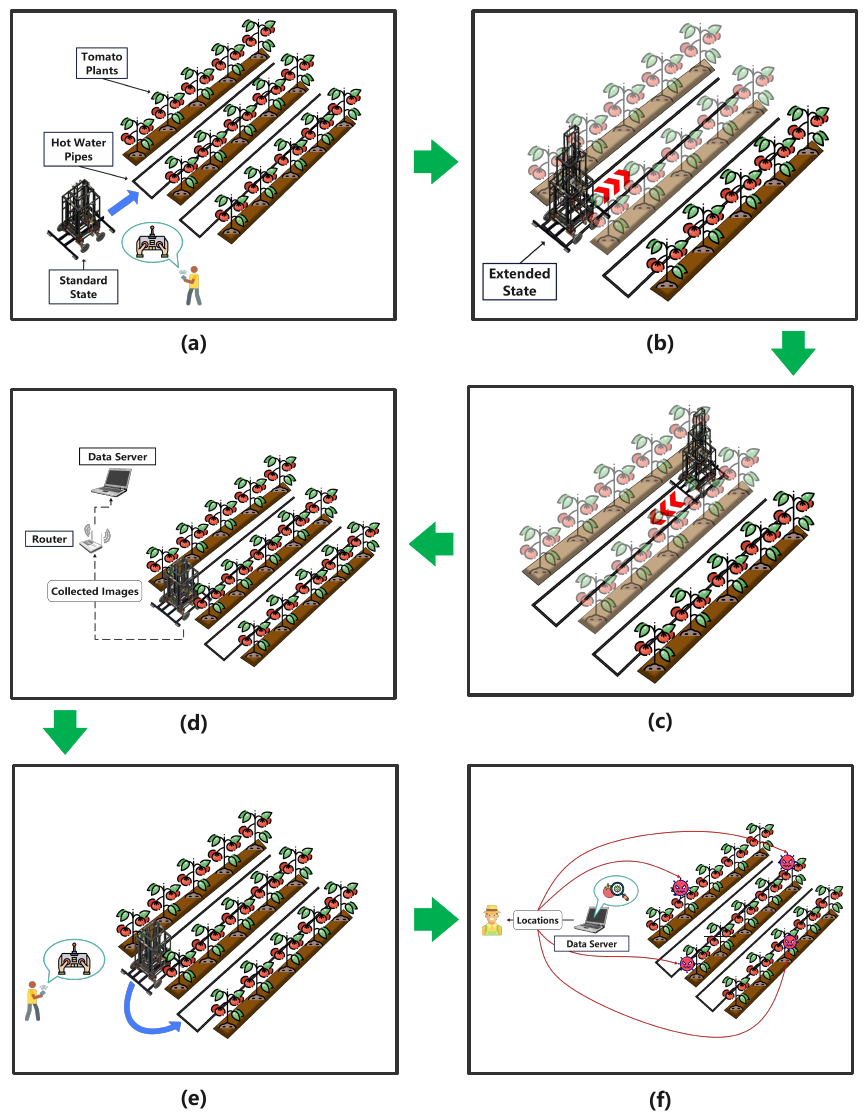
Figure 2. The workflow of the tomato disease monitoring system. ( a ) the user controls the robot to drive to the head of the hot water pipes using a remote controller; ( b ) the robot transforms to the extended state and automatically runs along the hot water pipes to collect image data of tomatoes; ( c ) when the robot reaches a predetermined position, it transforms back to the standard state and returns to the starting position; ( d ) the collected image data are sent to the server, and the robot waits for the user’s instructions; ( e ) the user controls the robot to drive to the next pipes, then ( b – d ) are repeated; ( f ) finally, a disease detection program run by the data server informs the user of the exact locations of diseased